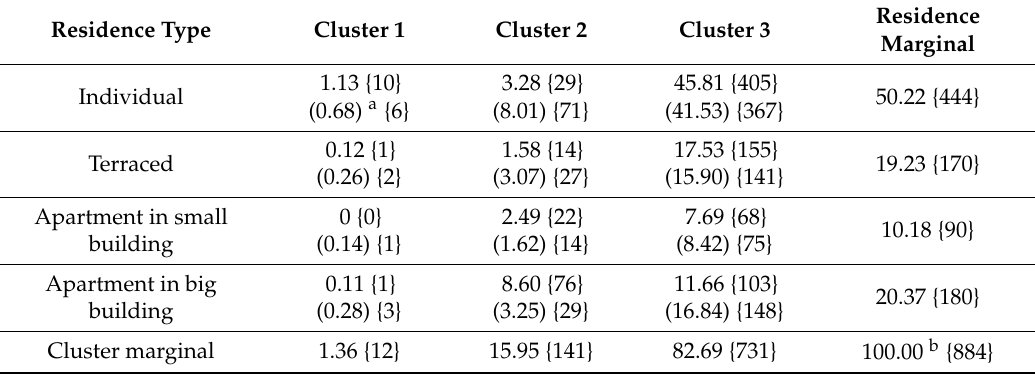
Table 7. Joint percentage distribution between residence type and